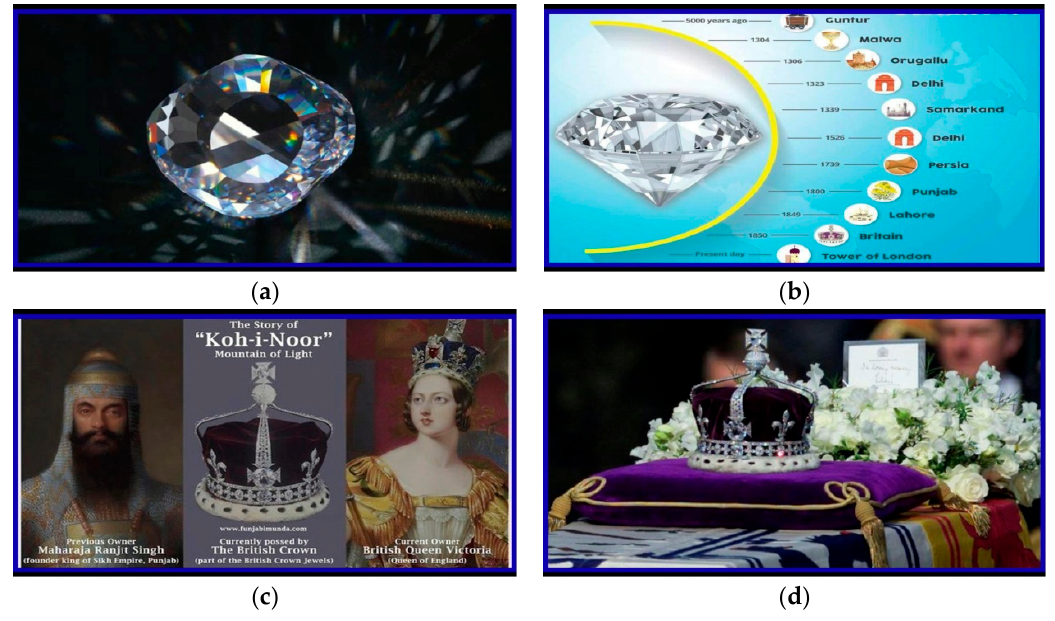
Figure 12. Stego Images ( a ) Image 1, ( b ) Image 2, ( c ) Image 3, ( d ) Image 4. The image quality determines the performance of the proposed embedding algorithm. Image quality is the difference between the stego image and original image. The various statistical parameters used to evaluate the image quality are given below. Average Difference: The Average Difference (AD) is the average of the difference between the cover image and the stego image, and is given by Equation (1). For the two same images, the average difference is zero. An average difference closer to zero indicates less distortion from the cover image.